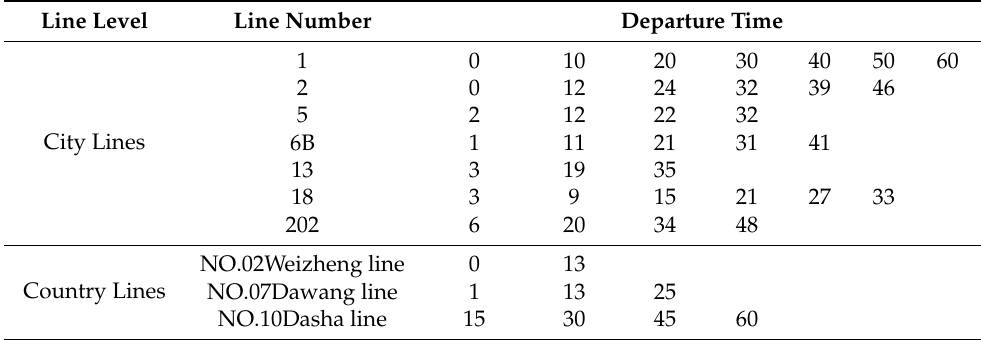
Table 8. Departure Schedule for Qian’an. Line Level Line Number Departure Time 1 City Lines